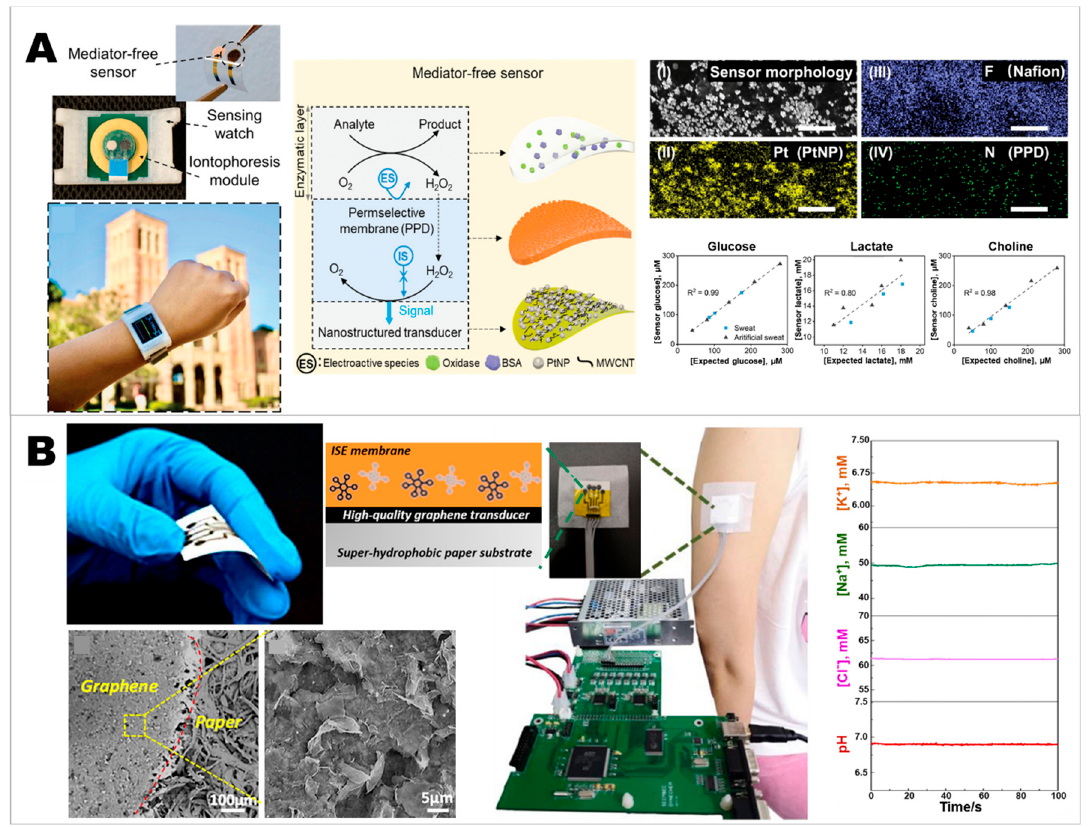
Figure 6. Examples of wearable sensors for monitoring multianalytes. ( A ) Mediator-free enzymatic sensors for the development of wearable glucose, lactate, and choline biosensors. Adapted with permission from [118], copyright 2019, Wiley-VCH. ( B ) The application of graphene-based materials to develop all-solid-state wearable potentiometric sensor for various ion monitoring. Adapted with permission from [122], copyright 20 19 , Elsevier.